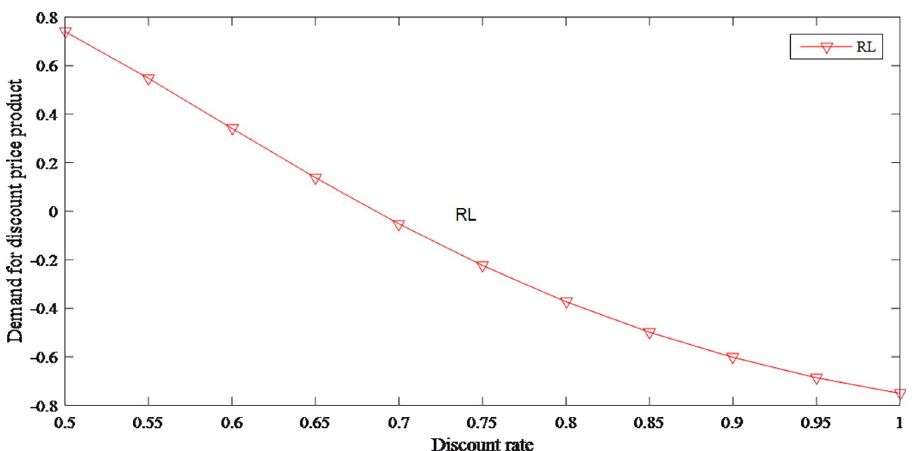
Fig 22. The impact of discount rate on demand for discount price product.